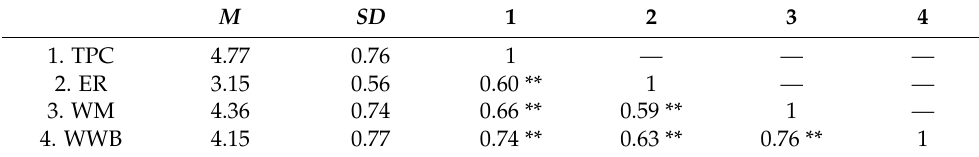
Table 2. Means, standard deviations, and inter-correlations between the main variables ( N = 1388). M SD 1 2